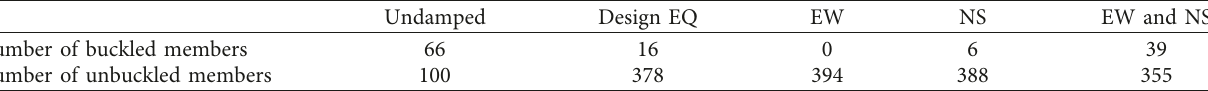
Table 7: Buckling conditions of all members in different earthquakes.